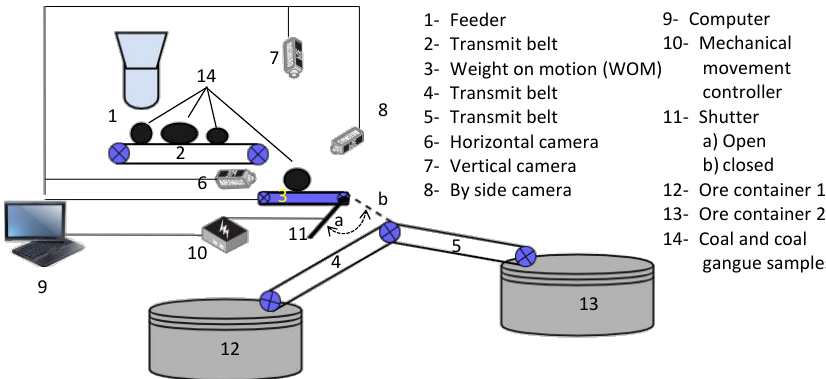
Figure 1. Separation System parts and separation